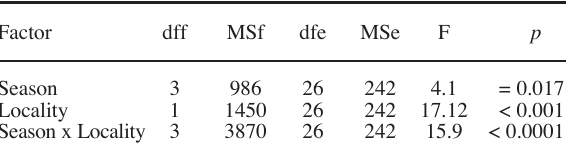
T ABLE 3. – Chasmagnathus granulatus . Summary of two-way analyses of variance of the proportion of mature ovaries in localities (SA and MC) and seasons (summer, winter, autumn and spring); dff: degrees of freedom of factors, MSf: mean squares of factors, dfe: degrees of freedom of errors, MSe: mean squares of errors, F = MSf / MSe, p : probability. Factor F IG . 7. – Chasmagnathus granulatus . Mean hepatosomatic index (± 1 standard deviation) of non-ovigerous and ovigerous females in San Antonio (SA) and Mar Chiquita (MC); asterisks indicate sig- nificant differences between ovigerous and non-ovigerous